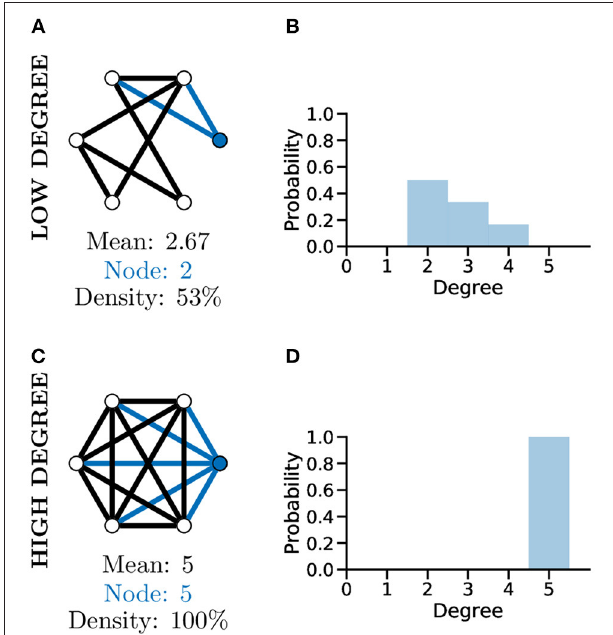
FIGURE 4 | Graph degree, degree distribution, and density all reveal information about how connected the nodes of a graph are. More connected graphs may represent fast flow of information in a network. A not well connected graph (A) with low density and thus low mean degree and individual node degree as shown by the degree distribution (B) . A “complete,” i.e., very well-connected, graph (C) with 100 % density and thus high mean and node degree and a different degree distribution ( D , c.f. B